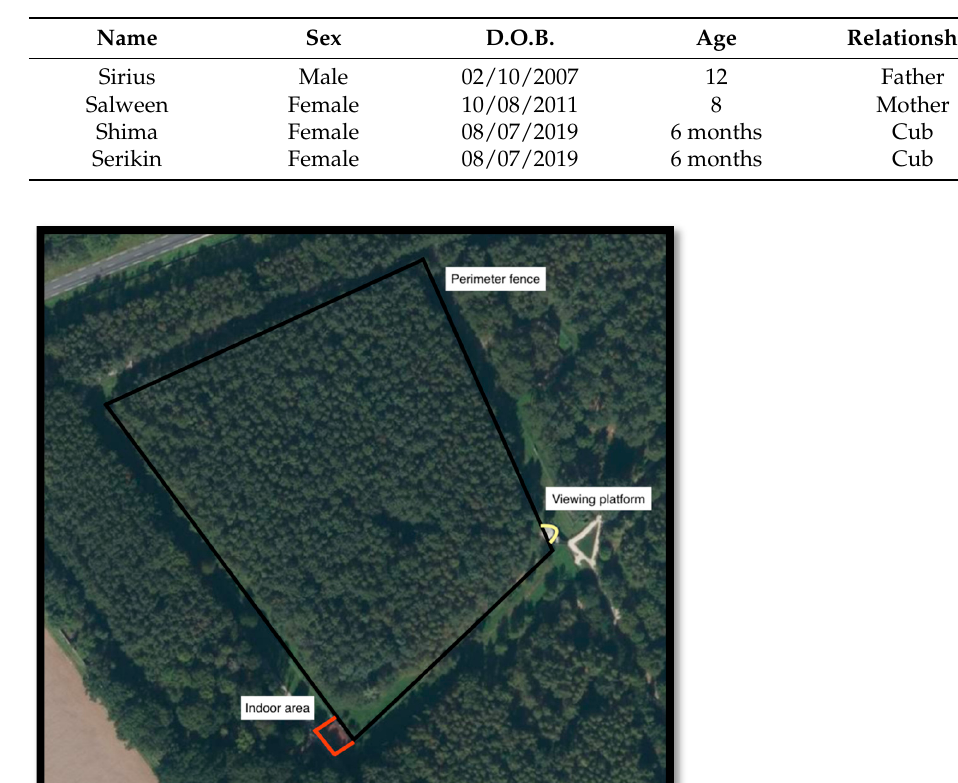
Table 1. Individual basic information on critically endangered (IUCN 2022) Malaysian tigers housed within Parc des Félins at the time of the study.